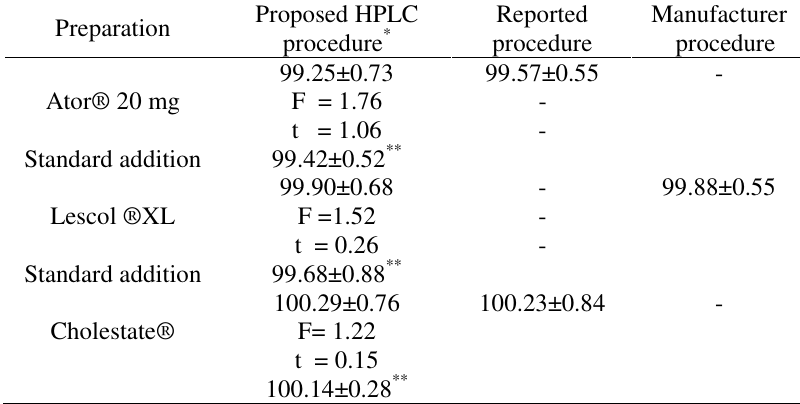
Table 2. Statistical analysis of the results obtained by applying the proposed, reported and manufacturer methods for the analysis of AT, FL and PV in their tablets